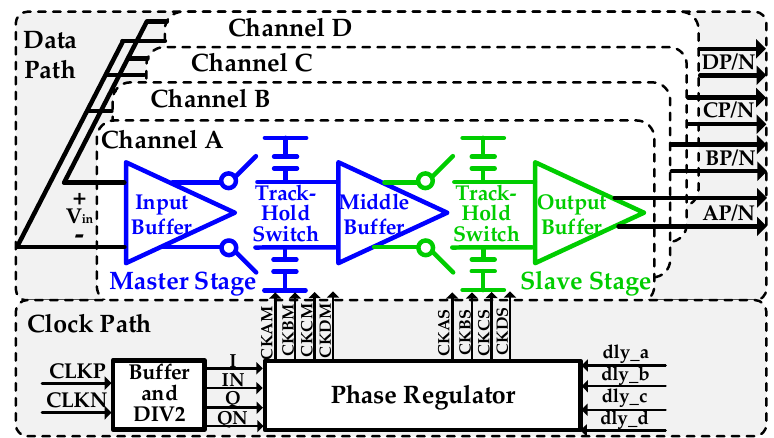
Figure 1. Block diagram of the proposed sample-and-hold amplifier.